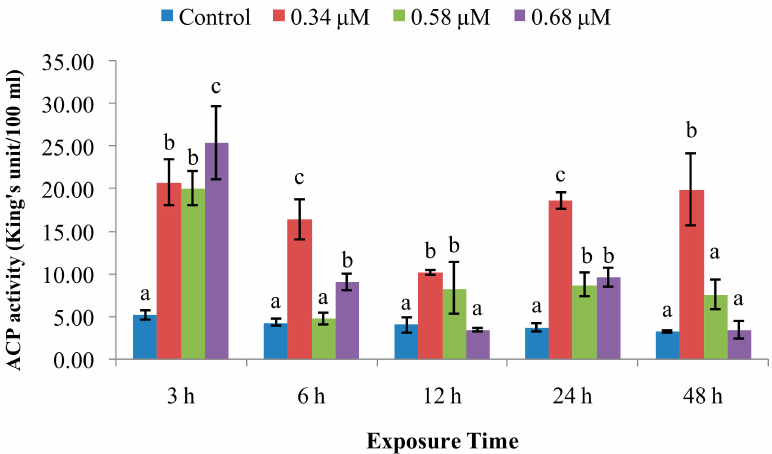
Figure 2. E ff ect of TD 49 on hemolymph acid phosphatase (ACP) activity at di ff erent time points after exposure to di ff erent concentrations (0, 0.34, 0.58, 0.68 µ M) of TD 49 . Data represent mean ± SD values ( n = 3) at the same time interval, with di ff erent letters denoting significant di ff erences ( p < 0.05). ALP activity (Figure 3) was significantly increased over control values at 3–12 hpe. Thereafter, it returned to near-normal levels at 24 and 48 hpe with one exception (0.34 µ M), which was high at 48 hpe. Peak ALP activities for the 0.58 µ M and 0.68 µ M groups were reached at 3 and 6 hpe, respectively.